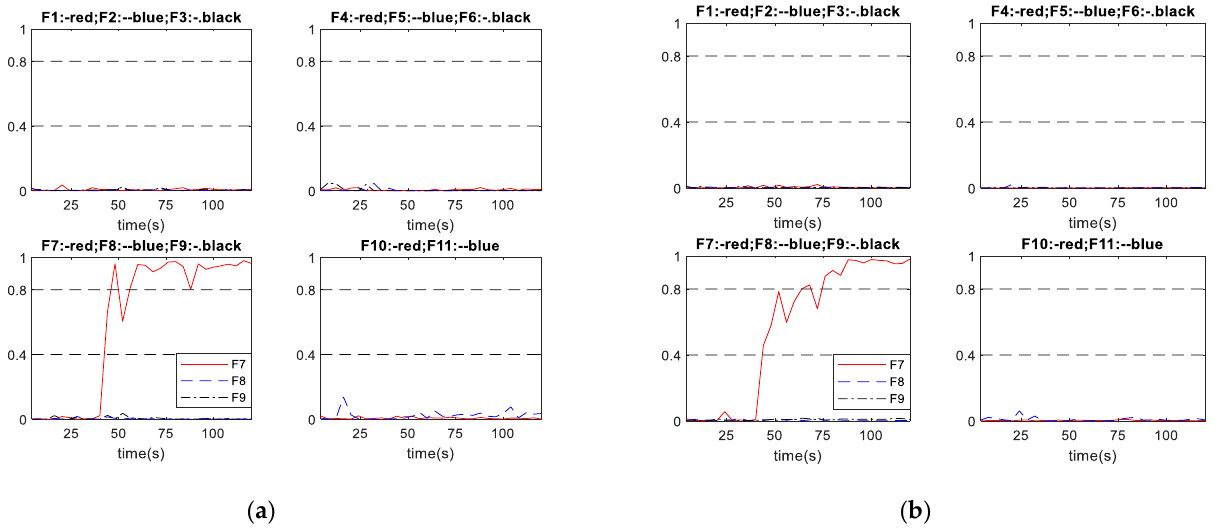
Figure 9. Diagnosis performance of scheme A ( a ) and scheme B ( b ) under abrupt fault No. 7 with relative magnitude of 27.86%.